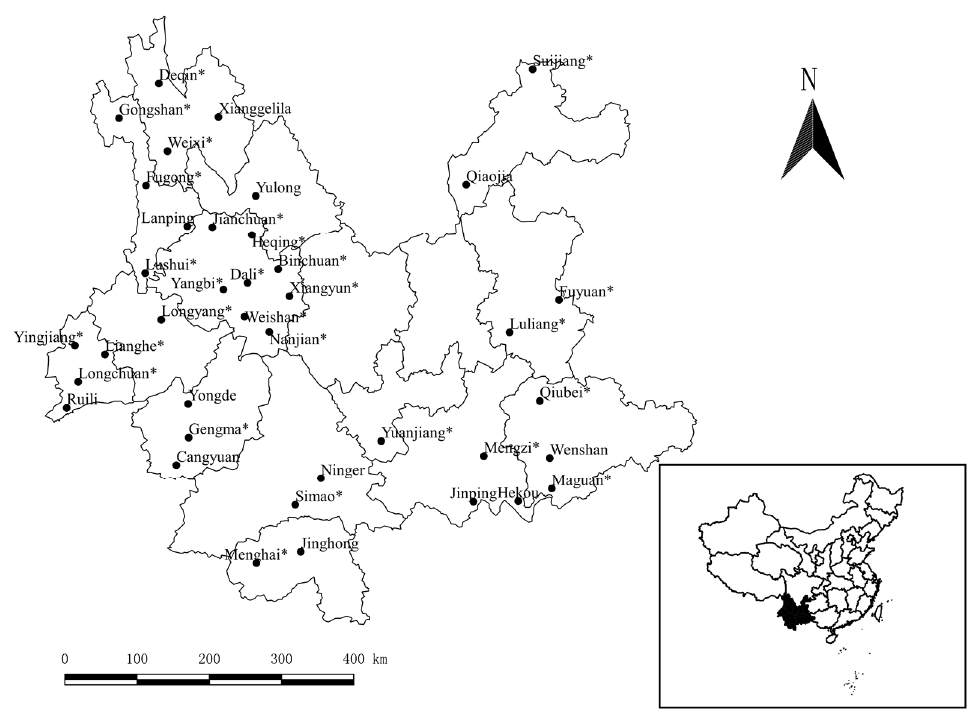
Figure 1. The 39 investigated counties and 27 counties with tropical rat mites ( Ornithonyssus bacoti ) collected (marked with “*”) in Yunnan Province, Southwest China (1990–2015).